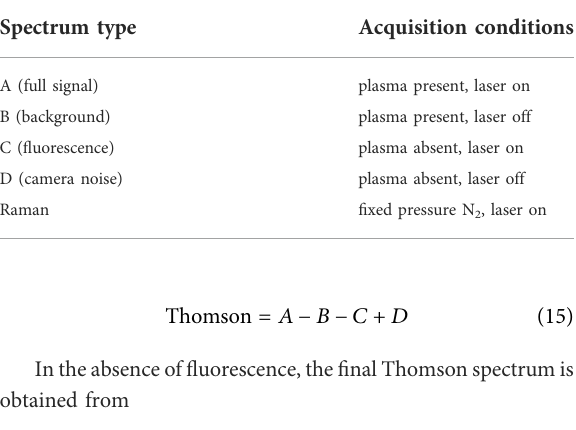
TABLE 3 Conditions used for signal